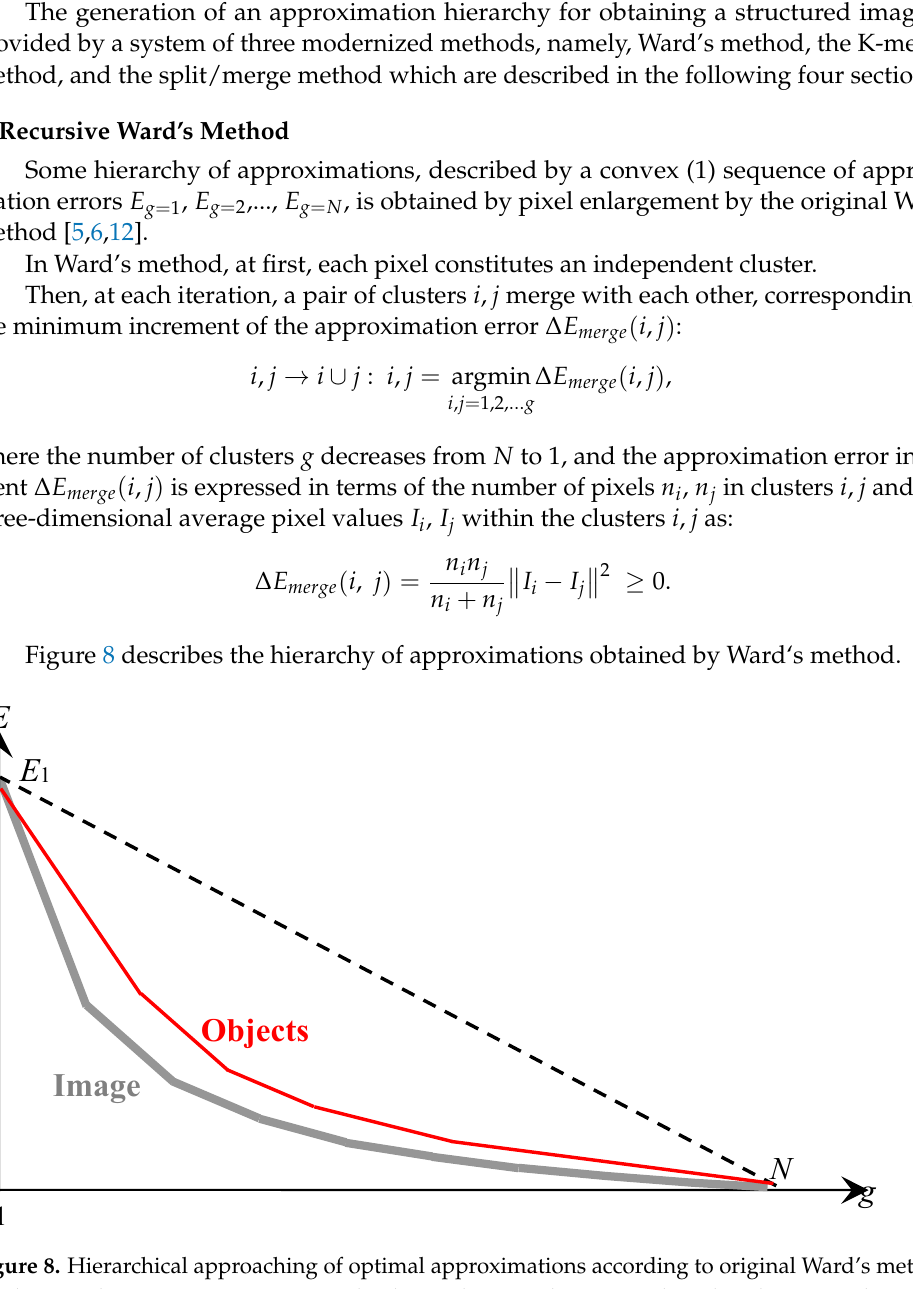
Figure 8. Hierarchical approaching of optimal approximations according to original Ward’s method. The limiting lower gray curve, assumed to be predominantly convex, describes the minimal approximation errors E g of the optimal image approximations depending on the number g of colors. The red solid convex curve describes approaching the image by the hierarchy of approximations for Ward’s pixel clustering. The dashed line shows the upper limit for both error sequences.